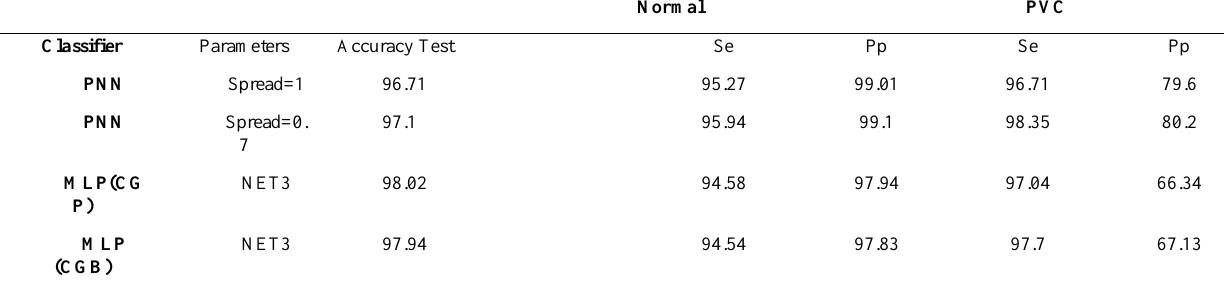
Table 6. Comparative results of PNN and MLP neural